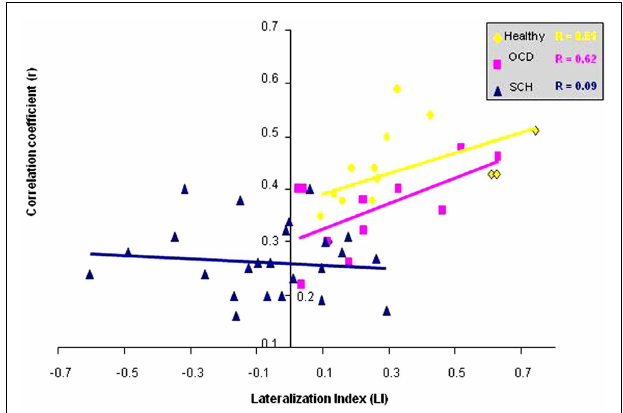
FIGURE 4 | Correlation between functional connectivity with left IFG and lateralization index is shown . Correlation between the r correlation coefficient from right IFG and the LI for the healthy controls, OCD, and all SCH